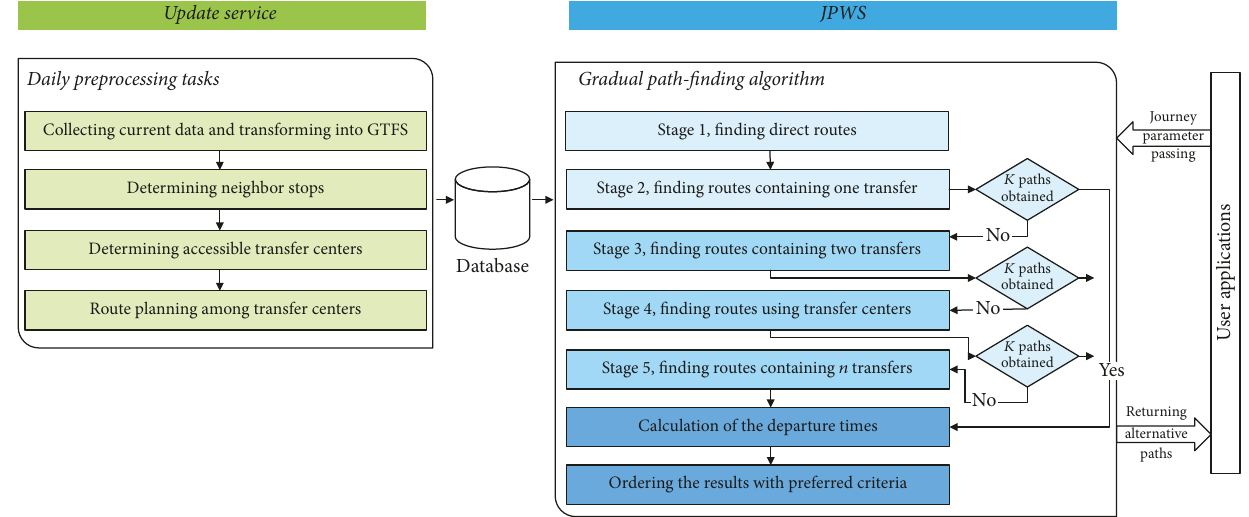
Figure 2: Algorithm schema of JPWS and Update Service